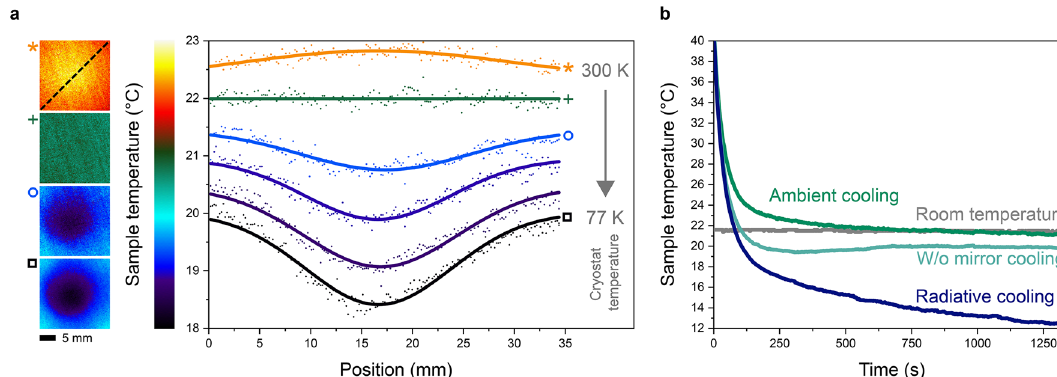
Figure 3. Temperature landscape variation and cooling efficiency. ( a ) Four IR images of the sample show the temperature distribution across the sample surface at four exemplary points in time during the radiative cooling experiment. The temperature profile has been extracted from the sample diagonal for various IR images (indicated by dashed line in the IR image on the top) and the respective distributions are plotted in the graph. Symbols correlate the curves to the images. During the cooling experiment, the central cryostat temperature was decreased from 300 to 77 K. ( b ) Comparison of the cooling process in the center of the sample for ambient conditions (green curve) with a cooling rate of 17.5 mK/s, cooling with the cryostat but without the mirror (petrol curve) radiative cooling (blue curve) with a cooling rate of 26.4 mK/s. Throughout the measurement, the room temperature was monitored as a reference (grey